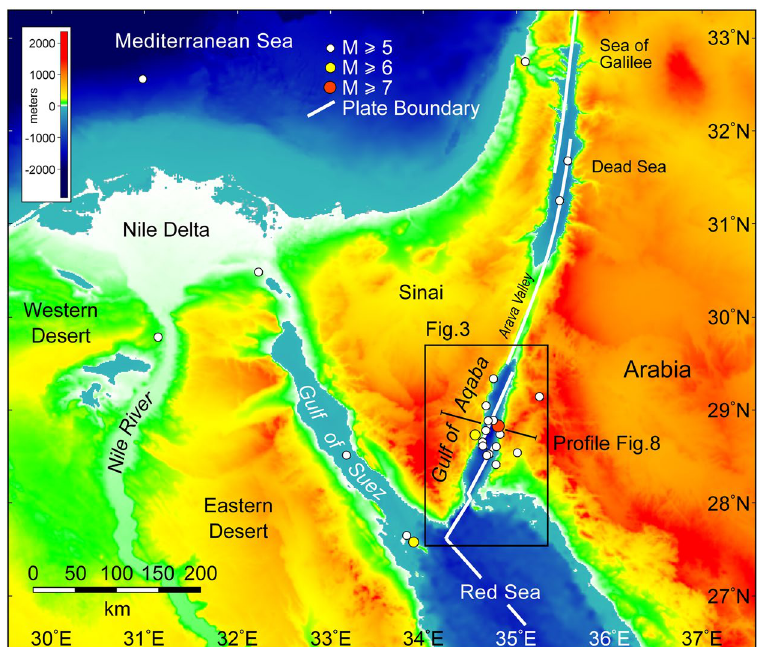
Figure 2. Digital elevation and bathymetric model for the Gulf of Aqaba and environs 47 . Epicenters for earthquakes with M ≥ 5 recorded from 1 January 1960 to 1 June 2016 are shown with colored dots 14 . Basemap was generated with Global Mapper v13.00 (http://www.bluemarblegeo.com/products/global-mapper- download.php). Location of Figs 3 and 8 are